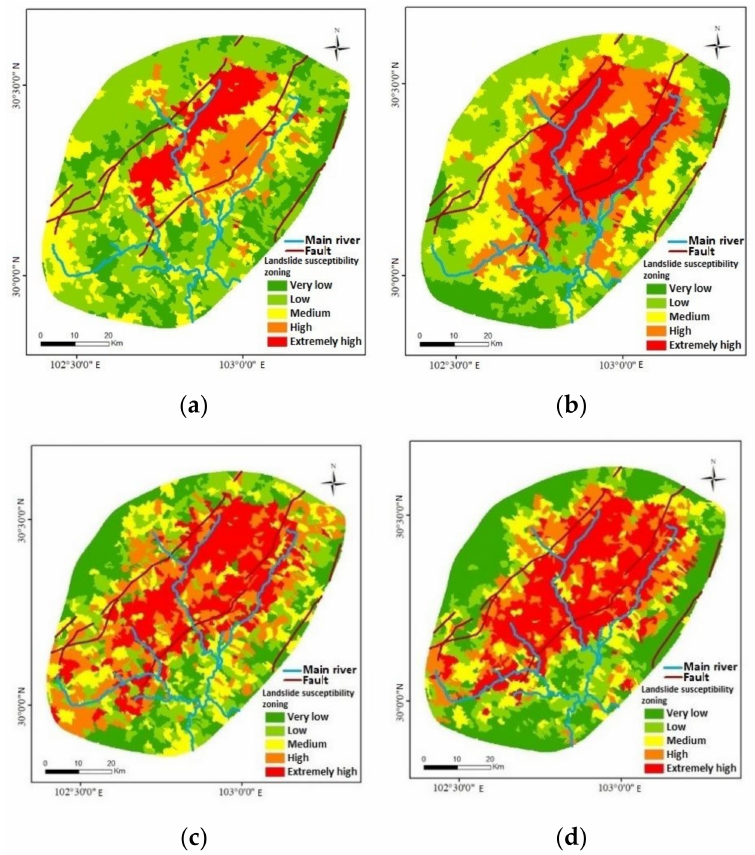
Figure 5. The relationship between the distribution of landslide susceptibility zones, rivers, and faults: ( a ) ANN; ( b ) LR; ( c ) RF; and ( d )